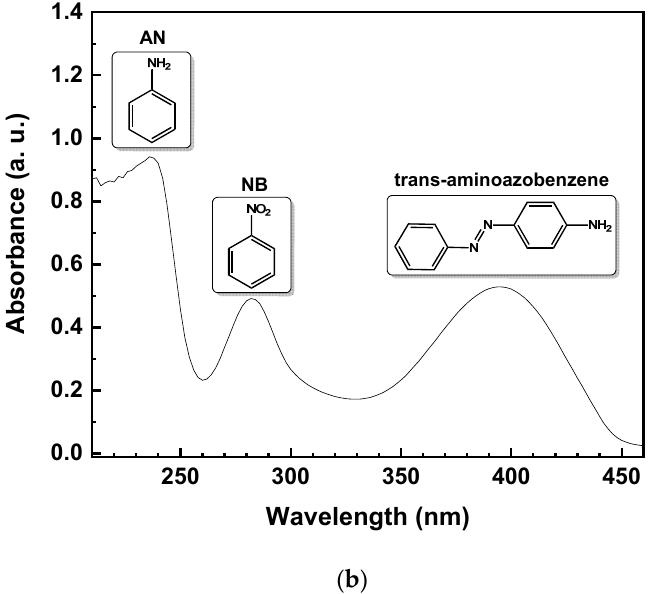
Figure 5. UV-vis spectrum of the aqueous solution with 10% EtOH ( v / v ) of NB initial solution ( a ) and after 15 min of UV irradiation time ( b ).